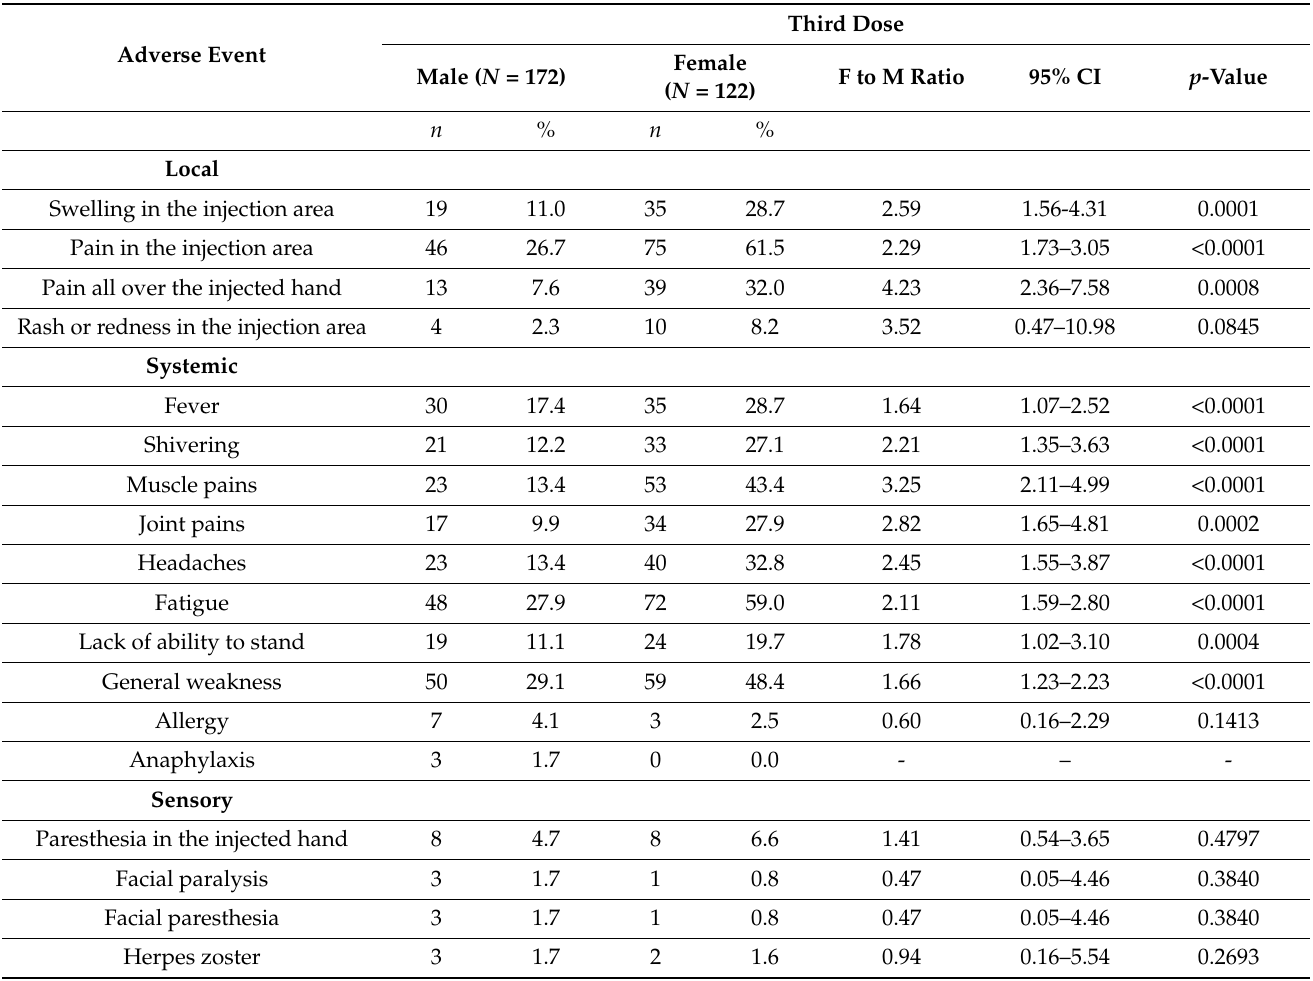
Table 4. Female-to-male ratio of the percentage reporting moderate or severe adverse events following the Pfizer-BioNTech COVID-19 third vaccine